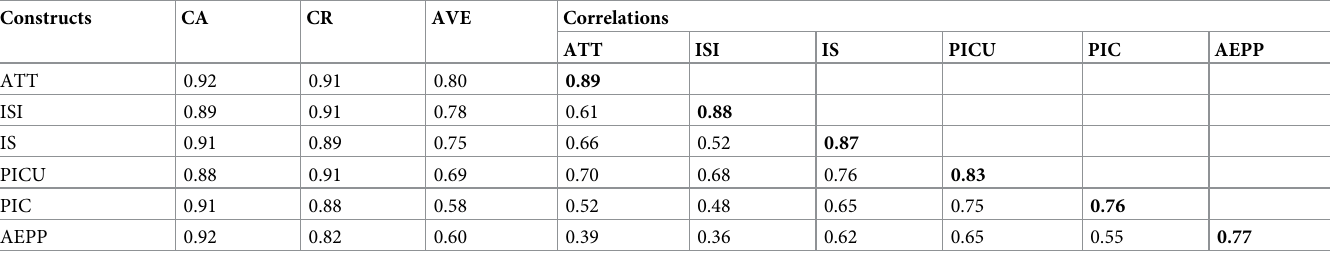
Table 5. Correlations, Cronbach’s alpha (CA), composite reliability (CR) and average variance extracted (AVE).